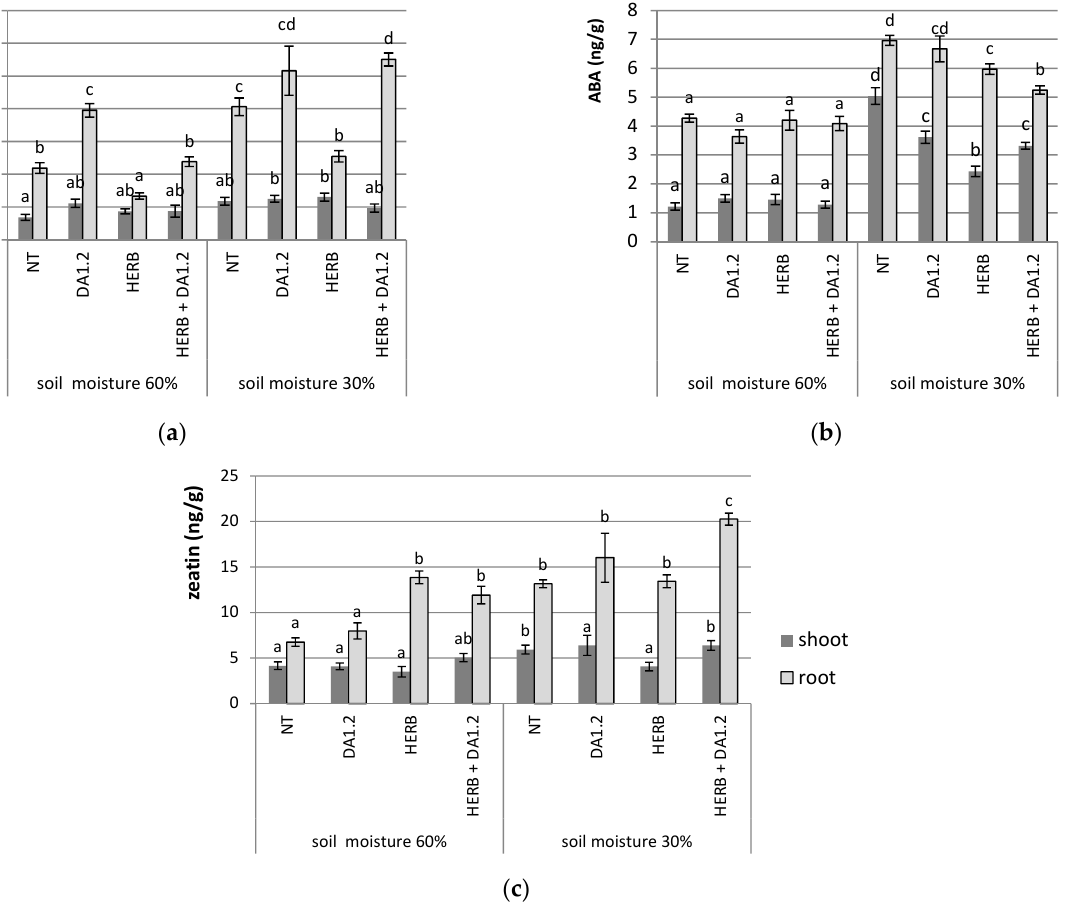
Figure 3. The amount of phytohormones in wheat leaves and roots: ( a ) indolylacetic acid; ( b ) abscisic acid; ( c ) zeatin. NT—no treatment was performed; DA1.2—bacterial treatment with Pseudomonas protegens DA1.2; HERB—herbicide treatment. Statistically different means are indicated by different letters ( p ≤ 0.05, n = 6).